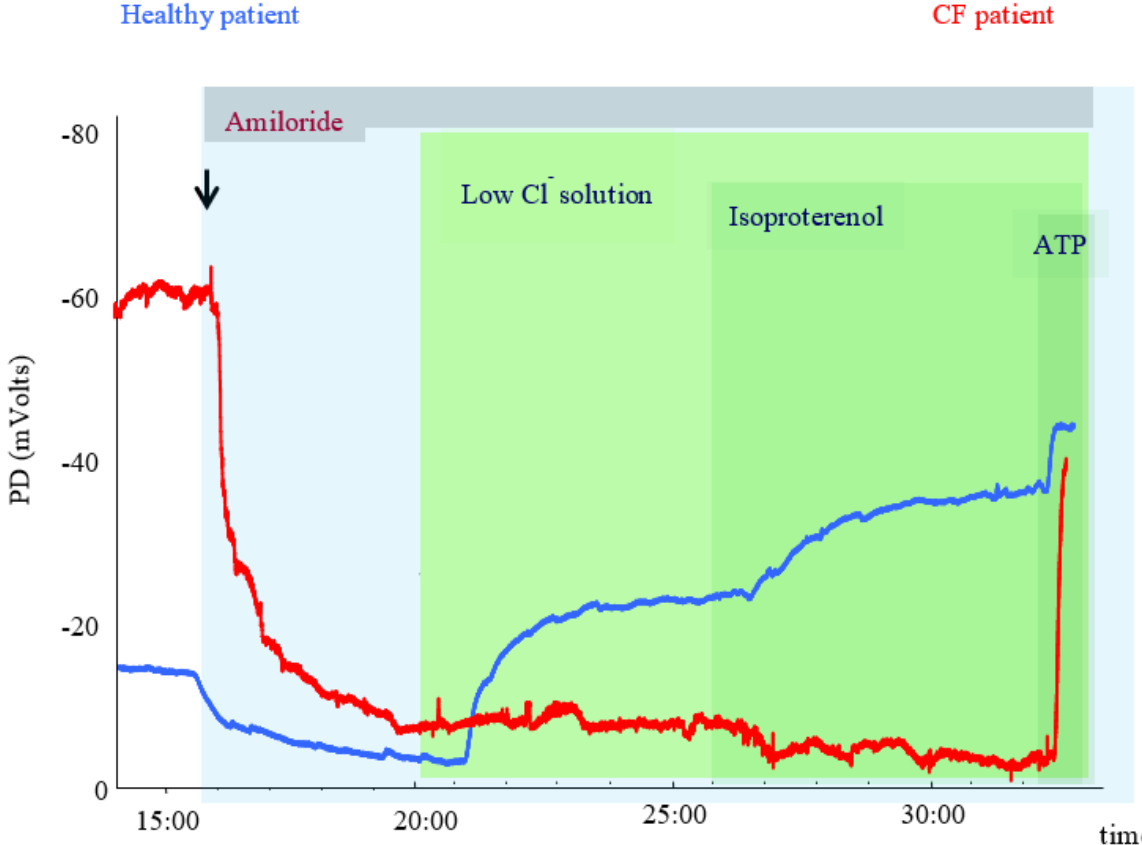
Figure 2. NPD tracing in a healthy control and in an F508del homozygous patient.